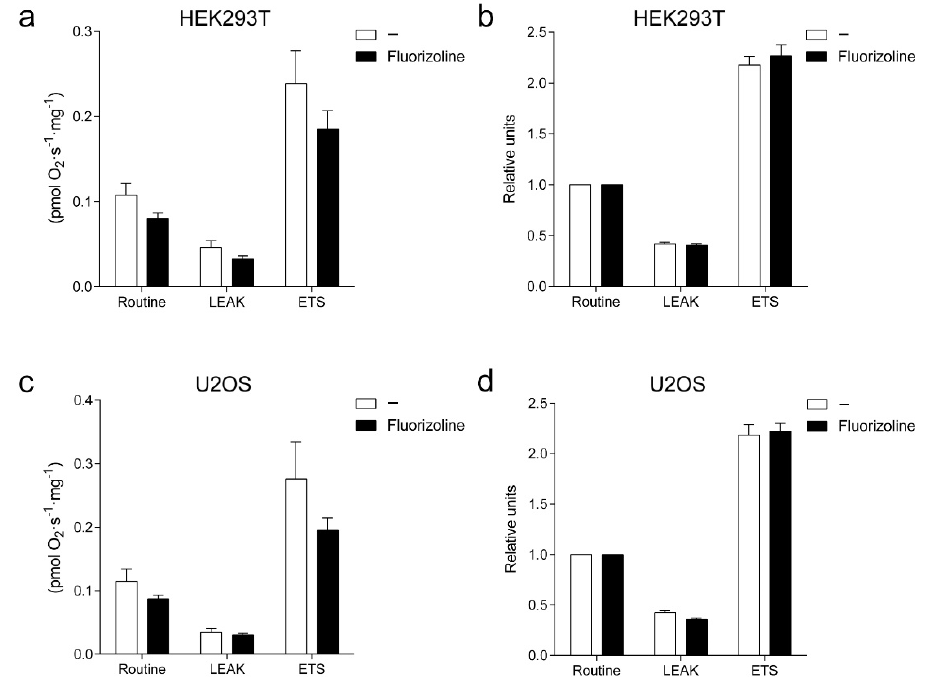
Figure 5. Fluorizoline does not alter mitochondrial respiration in HEK293T and U2OS cells. ( a , b ) HEK293T cells and ( c , d ) U2OS cells were treated with 15 or 20 µ M fluorizoline (F) for 4 h. Oxygen consumption was measured in basal conditions (Routine) after the addition of 1 µ M antimycin A (LEAK) and after titration with 0.5 µ M CCCP (ETS). Data are represented as ( a , c ) raw oxygen consumption rate and ( b , d ) oxygen consumption relative to Routine ( n =